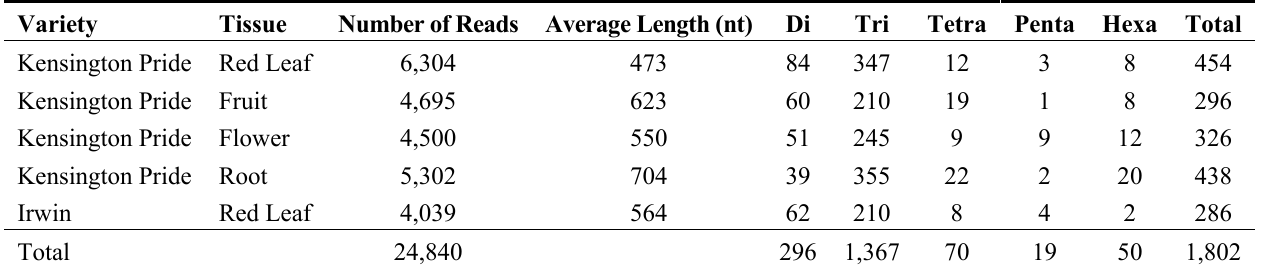
Table 2. EST-SSR nucleotide repeat motifs in mango